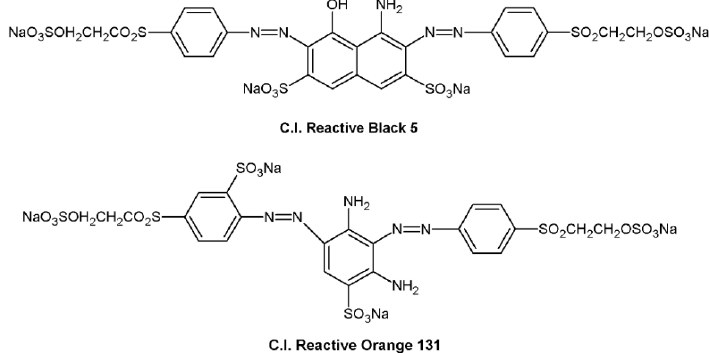
Figure 1. Chemical structure of the anionic dyes used in this study.